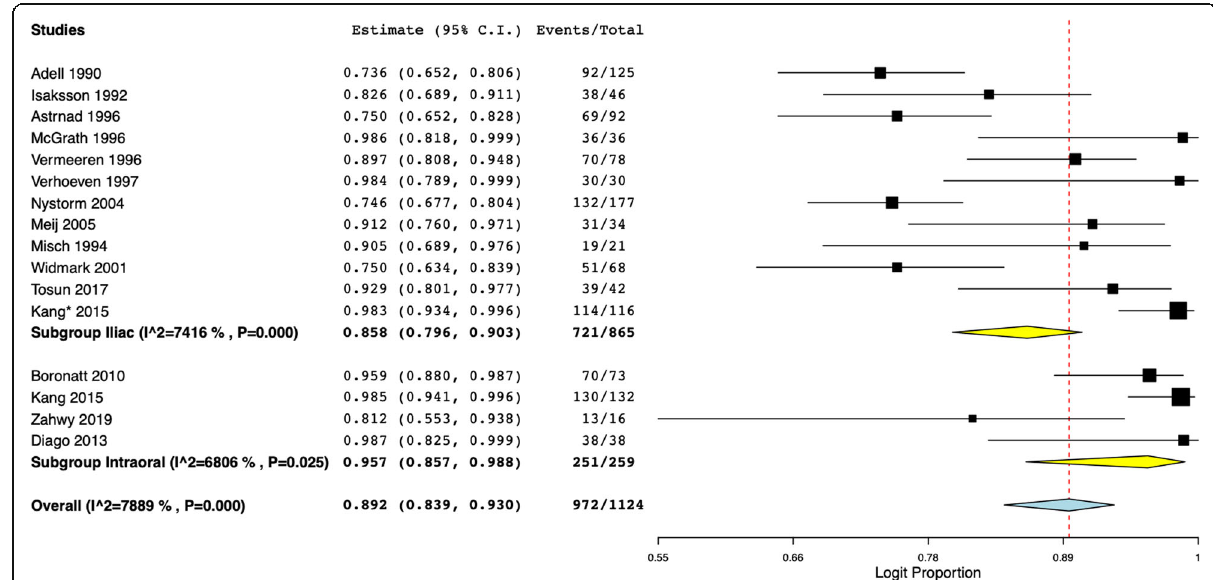
Fig. 4 Meta-analysis of implant survival with sub-group analysis based on type of onlay graft